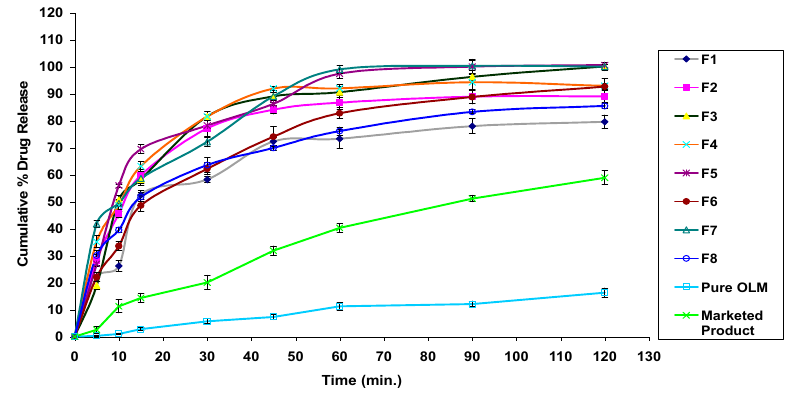
Figure 6. In vitro release profiles of OLM SNEDDS formulae compared with pure OLM and marketed product.